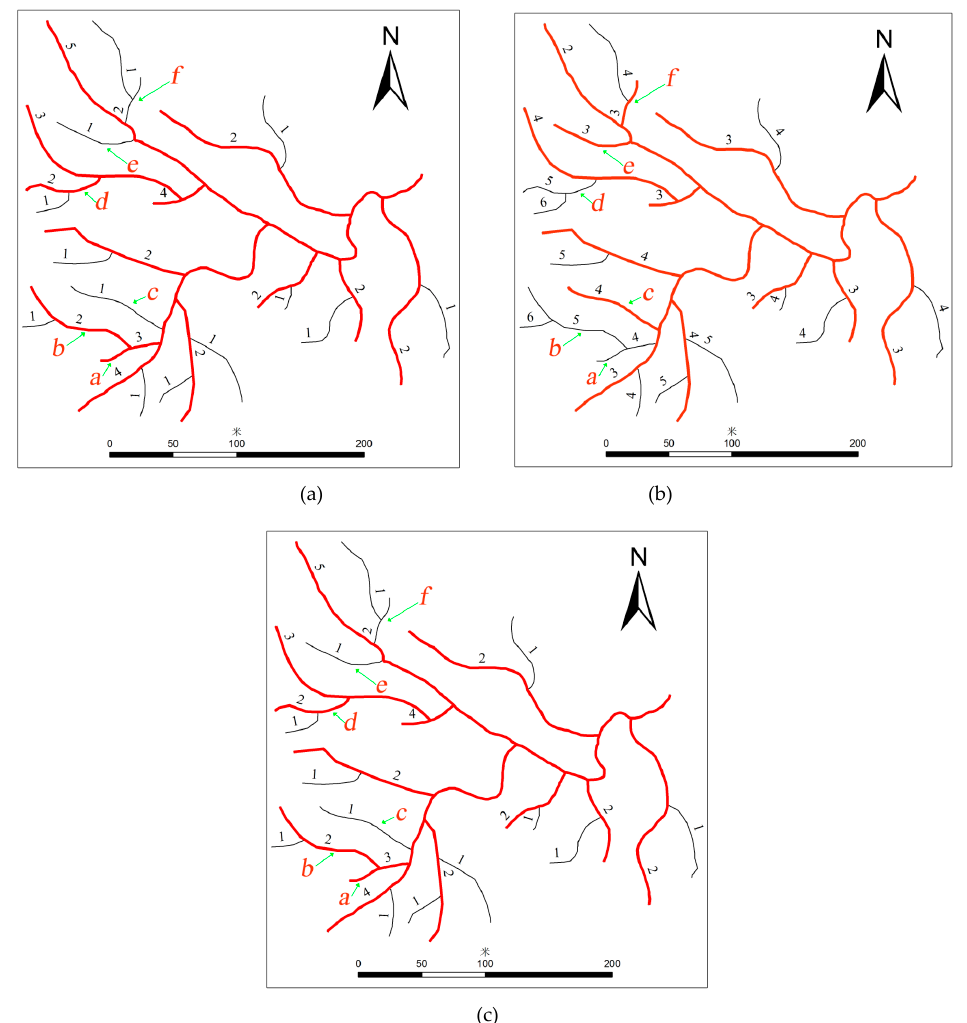
Figure 12. Comparison of the selections in a deep branch: ( a ) selection result based on the top-down coding method, ( b ) selection result based on bottom-up coding method and ( c ) selection result based on the hybrid coding method (the selection results are shown as red lines, and the original rivers are shown as black lines).